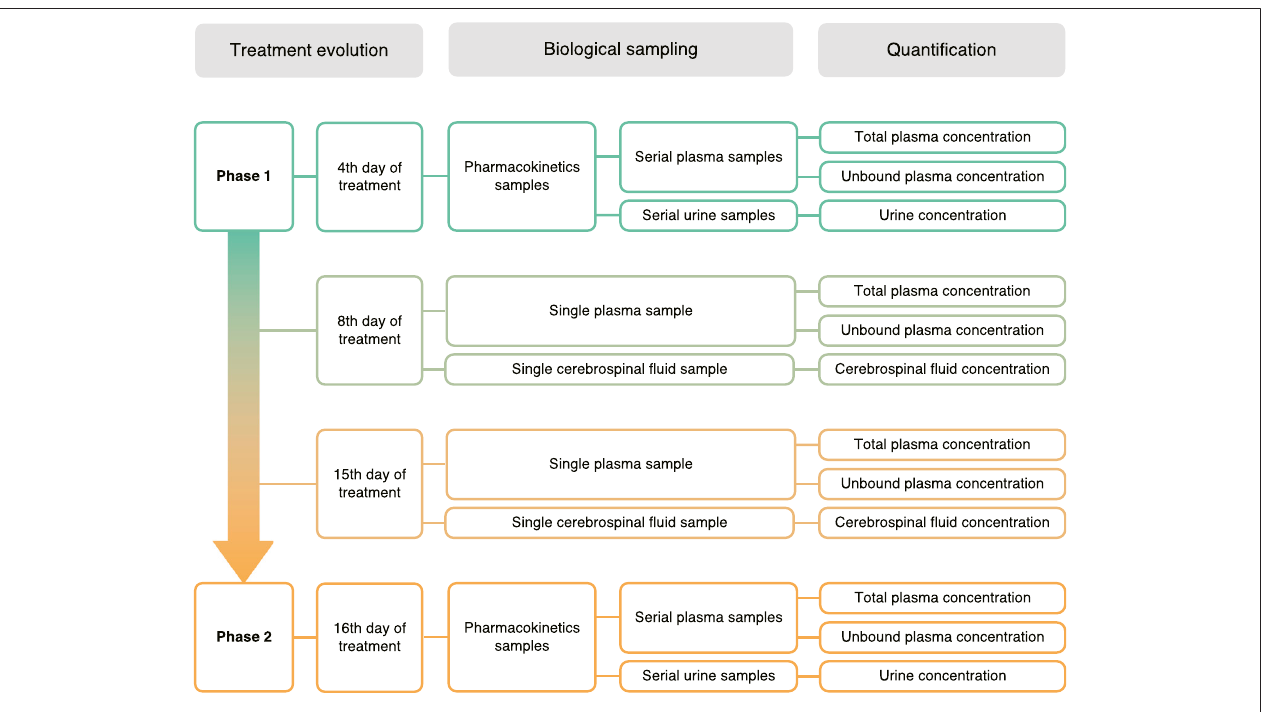
FIGURE 1 | Clinical protocol and biological sampling